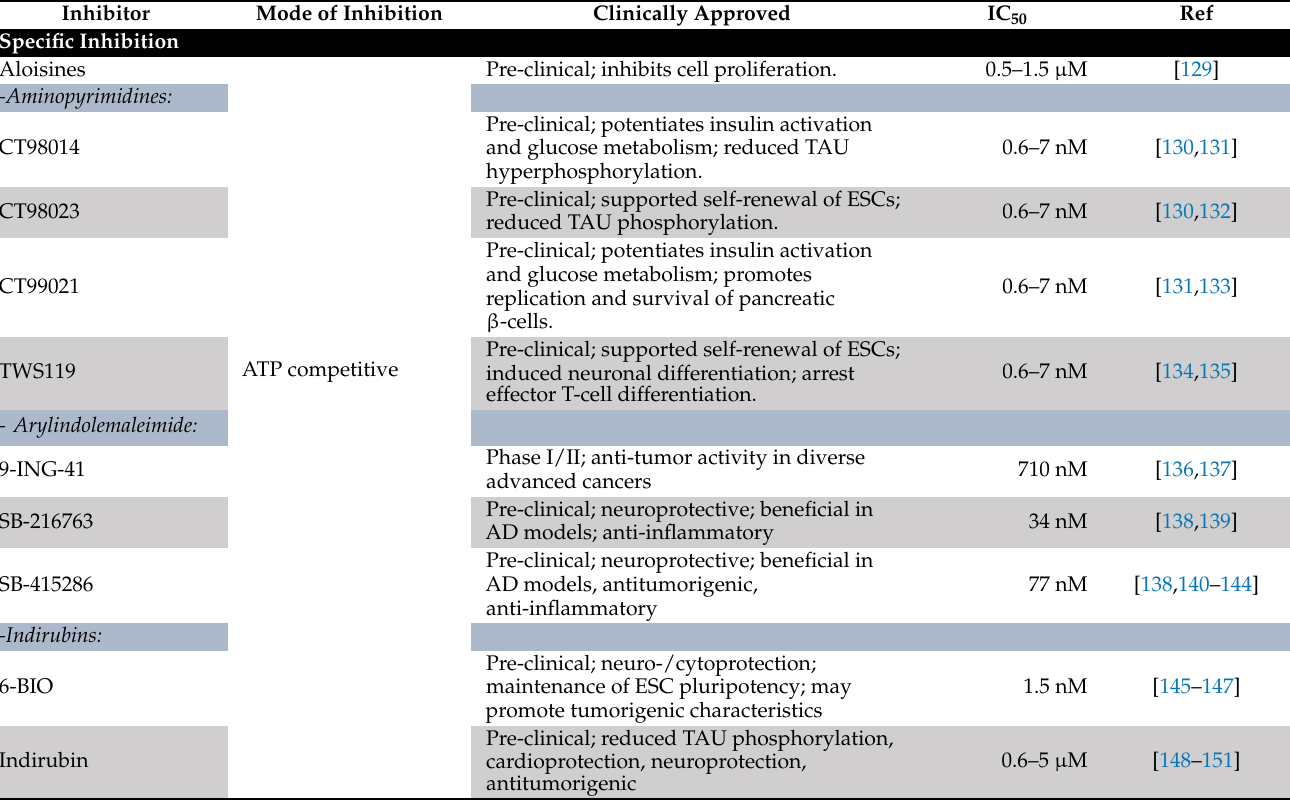
Table 4. A list of GSK3